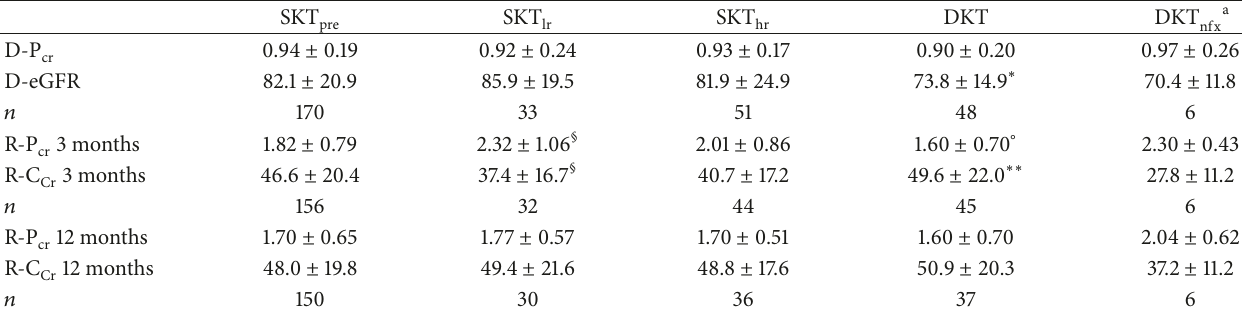
Table 4: Plasma creatinine (P , mg/dL) and GFR (Cockcroft-Gault formula in donors or 24 h-creatinine clearance in recipients) in donors cr (D) and recipients (R; at 3 and 12 months) in each transplant category (data are number, and mean ± SD).